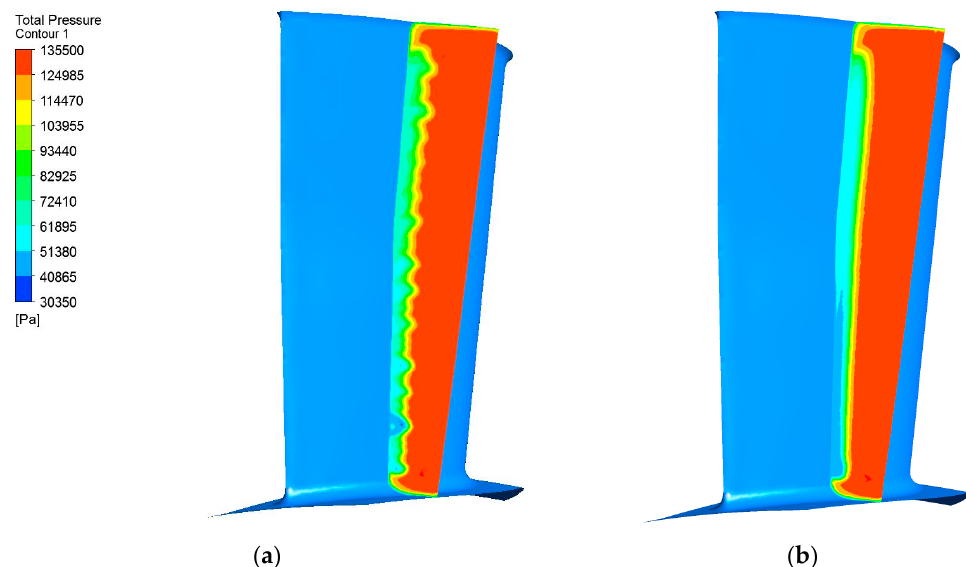
Figure 10. ( a ) Total pressure distribution for 𝜏 = 53.6% ; ( b ) Total pressure distribution for 𝜏 = 75% .